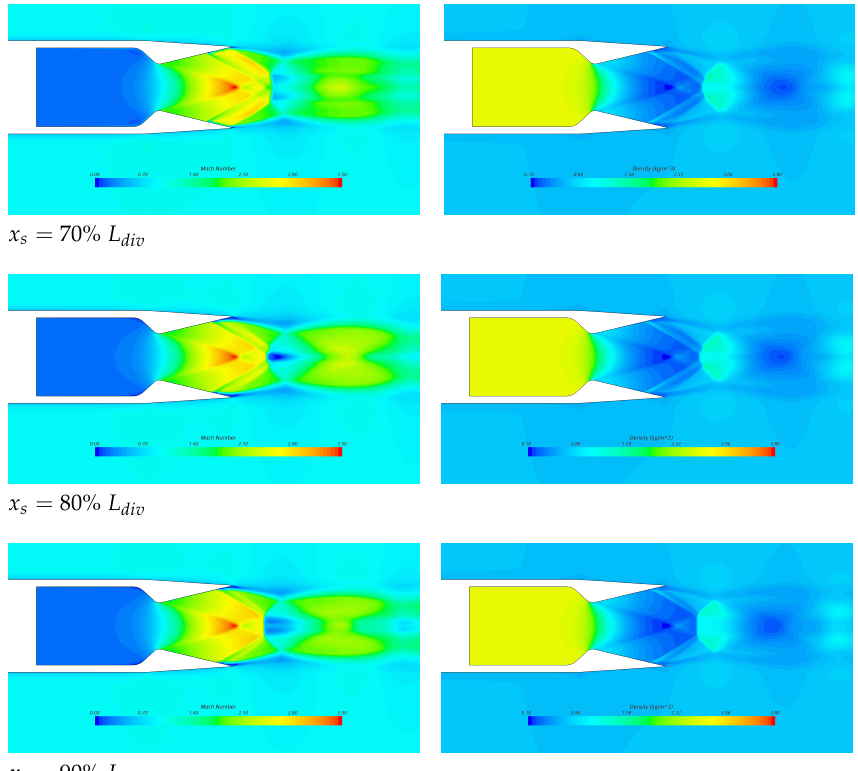
Figure 11. Mach number ( left ) and density ( right ) fields for axisymmetric injection at different positions in the nozzle divergent.